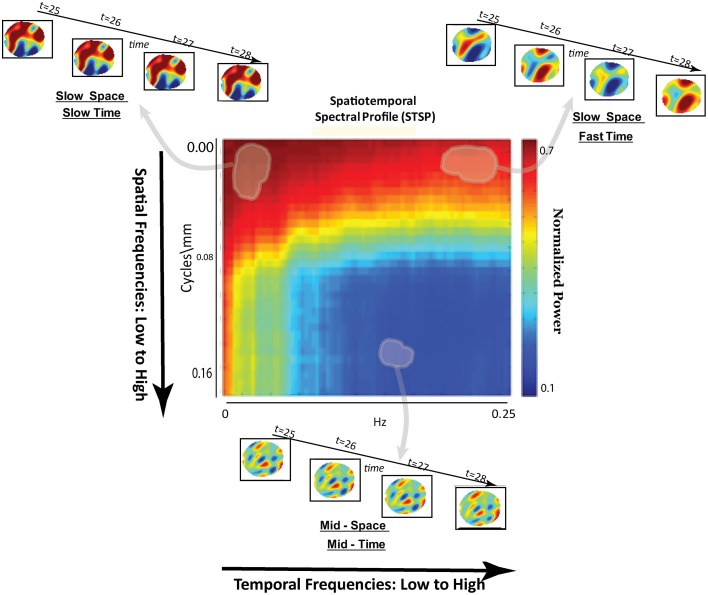
Schematic breakdown of spatiotemporal spectral profile (STSP) with arrows to examples of subject data filtered for content in indicated spatiotemporal frequency bands.